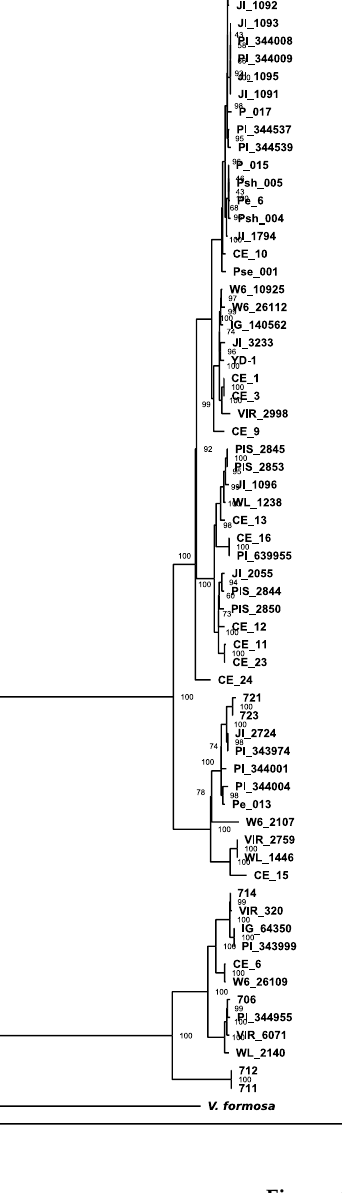
Figure 4. Phylogenetic tree of the studied pea accessions reconstructed on the basis of the mitochondrial genomes using Maximum Likelihood method. Designations as in Figure